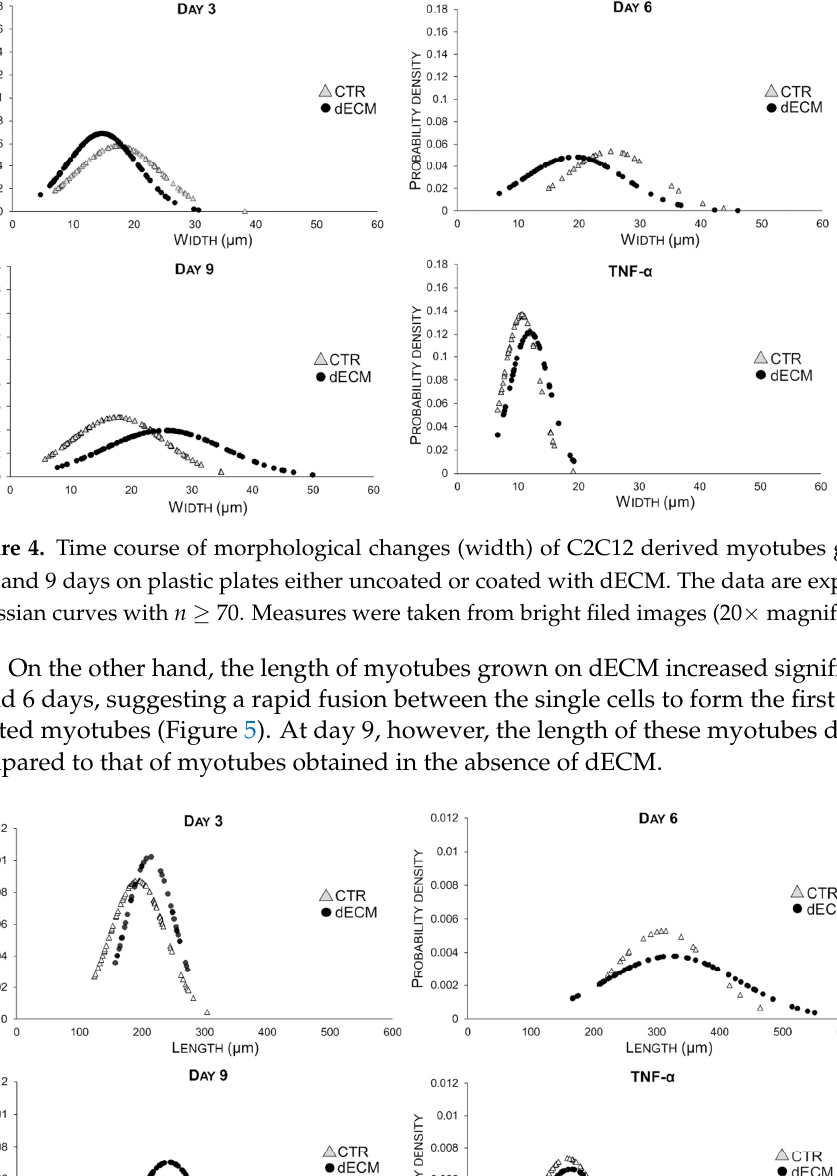
Table 1. Comparison of the morphological features (width, left and length, right) of myotubes originated from C2C12 cells grown on plastic plates either uncoated or coated with dECM. Values are expressed in micrometers mean ± SD and were obtained from a minimum of 70 myotubes. * p < 0.05, ** p < 0.01, *** p < 0.001. Myotubes CTR dECM p Values Width (µm)